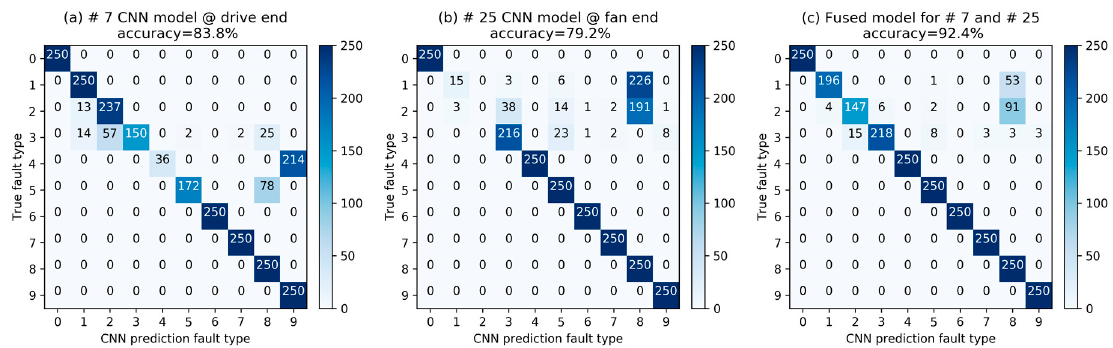
Figure 10. Performance comparison of DSCNN vs IDSCNN on C → A test. 4. Conclusions This paper presents IDSCNN, an ensemble convolutional neural network model with improved D-S evidence fusion for bearing fault diagnosis. We proposed an improved fusion algorithm based on the traditional D-S evidence theory by rectifying the raw evidence through evidence credibility, which helps to address its paradox evidence issues. Our extensive experiments on the Case Western Reserve University (CWRU) bearing datasets showed that the traditional D-S fusion method fails to combine the evidences/signals from two sensors located at the fan-end and drive-end of the testing rig due to evidence conflicts. On the other hand, our IDSCNN model can deal with four common